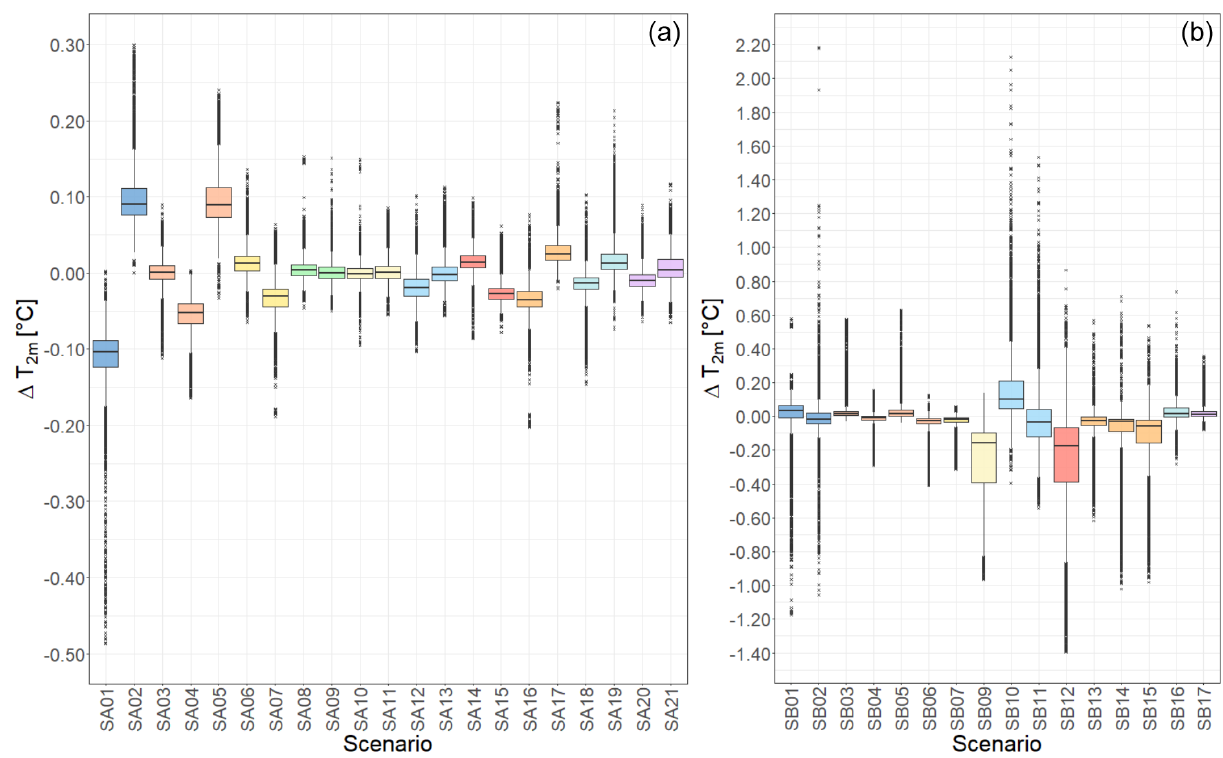
Figure 3. Sensitivity of air temperature in SA (a) and SB (b) scenarios. Values represent grid box differences (scenario − baseline) of 24h averages in the first 2m high layer. Box colours indicate related scenarios (e.g. blue for changing albedo, orange for changing emissivity). Whiskers: values within 1 . 5 × the interquartile range; crosses: outliers.